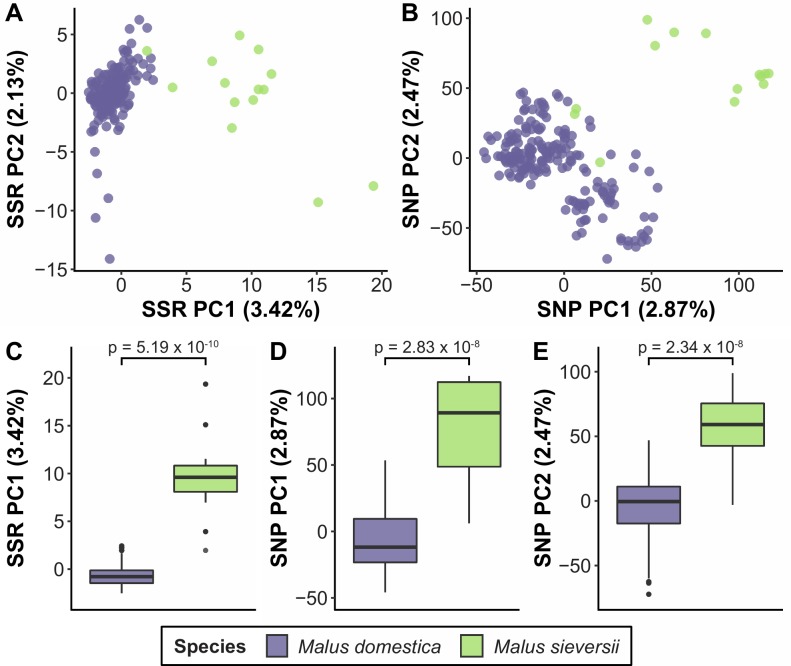
Principal components analysis (PCA) based on (A) SSR and (B) SNP data for 204 accessions. Accessions are labelled based on species, and boxplots of species distribution along (C) SSR PC1, (D) SNP PC1 and (E) SNP PC2 are included. The percentage of variance explained by each PC is indicated in parentheses. Results from Mann-Whitney U-tests between Malus domestica and M. sieversii are also reported.